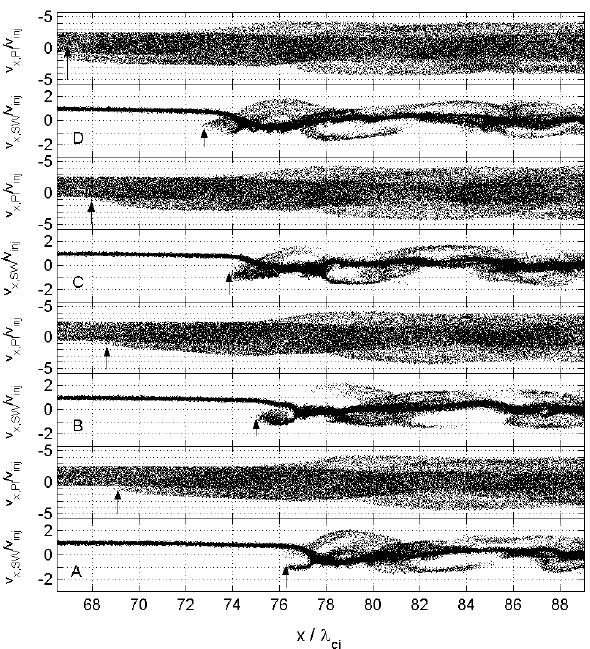
Fig. 5. Four pairs of panels, corresponding to the spatio-temporal Fig. 4. Phase space ( v x /v inj vs. x/λ ci ) for solar wind protons coordinates of the panels in Fig. 4, showing perpendicular magnetic (lower panel of each pair) and pickup protons (upper panels) in field strength (upper panel of each pair), and φ = R E x dx (lower pan- the shock region. Four pairs of panels at equal time intervals of els) in the shock region. As in Fig. 4, the maximum upstream po- 0 . 4 × 2 πω − 1 , starting at time t = 33 . 3 × 2 πω − 1 (lowest two pan- sitions of reflected protons for each species are indicated, with the ci ci els). The maximum upstream position for the reflected ions in each furthest upstream arrow relating to the pickup ion species are indicated for each snapshot.